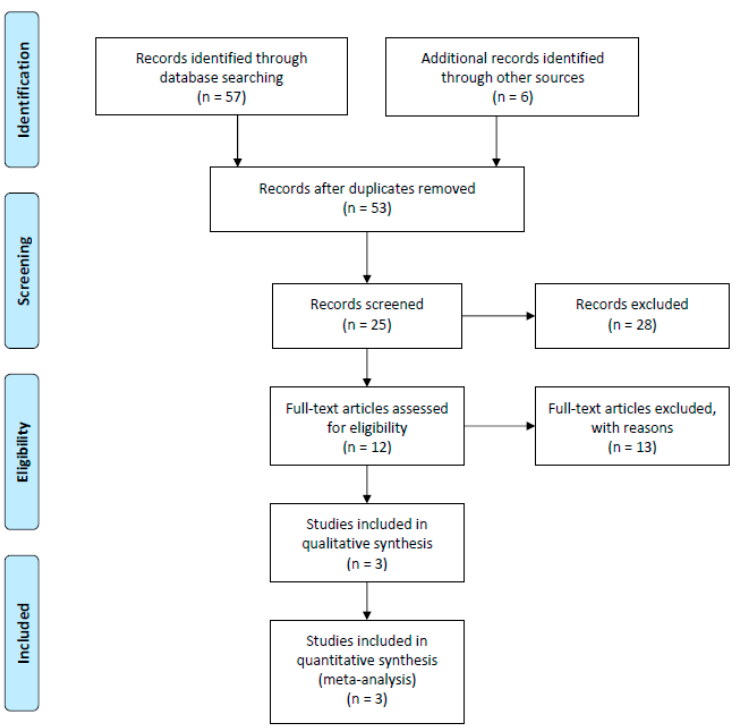
Figure 1. PRISMA Flow Diagram of literature research. The PRISMA Group (2009).